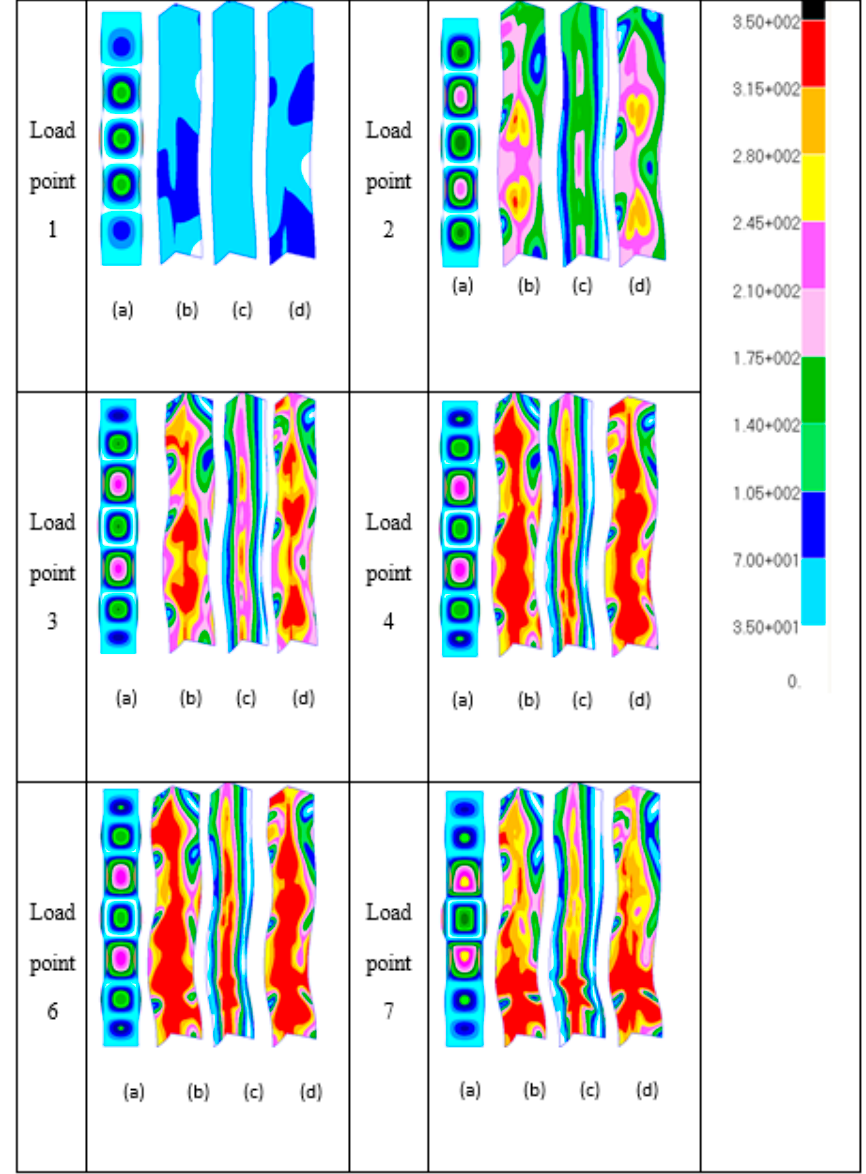
Figure 10. Deformation plots ( a ) and growth of von Mises stresses with load (( b ) outer surface 1; ( c ) middle surface; and ( d ) outer surface 2) of Figure 8 (quarter-model).